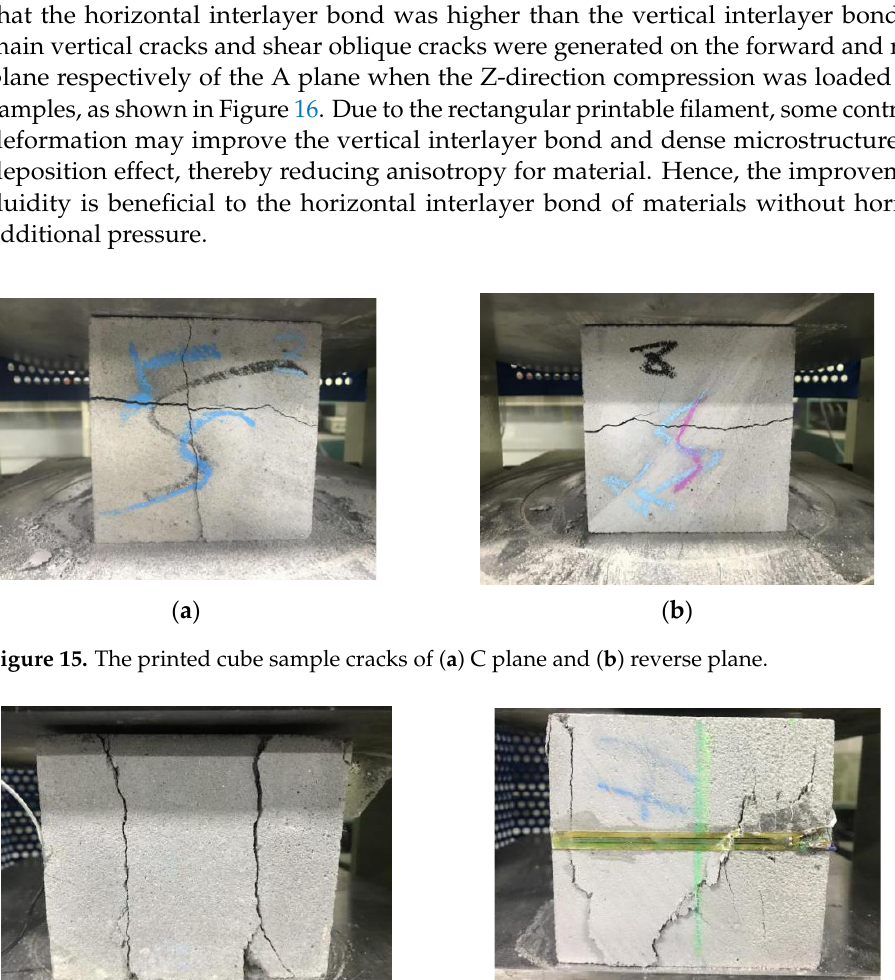
Figure 14. The printed cube sample cracks of ( a ) C and ( b ) reverse plane on the X-direction com- pression.